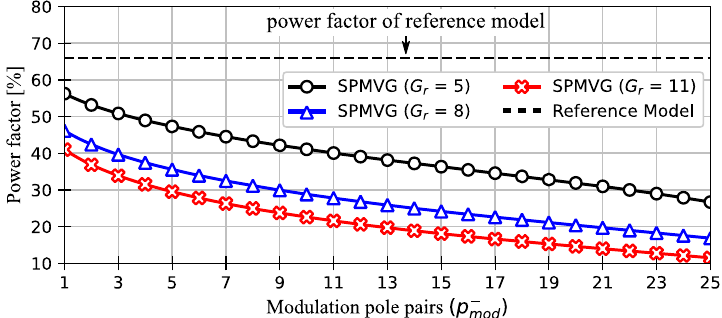
Figure 9. Variation of power factor ( 𝐺 (cid:3045) = 5,8, 11 and 𝑝 (cid:3040)(cid:3042)(cid:3031) (cid:2879) = 1~25